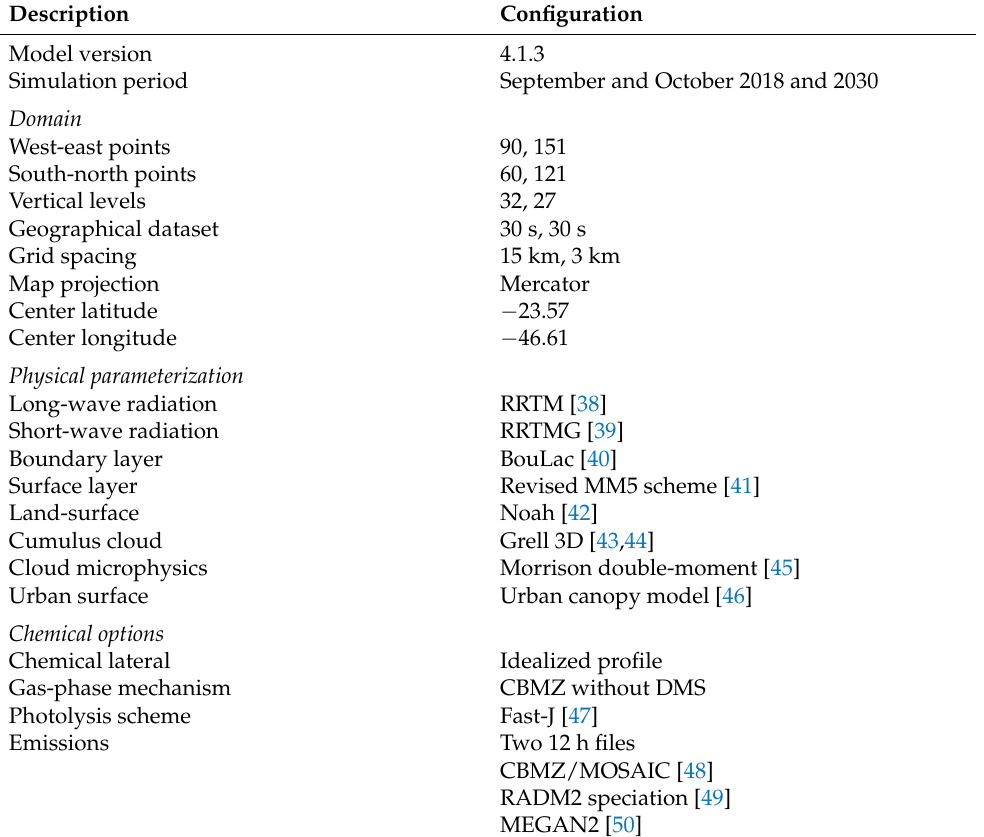
Table 1. Physical and chemical model